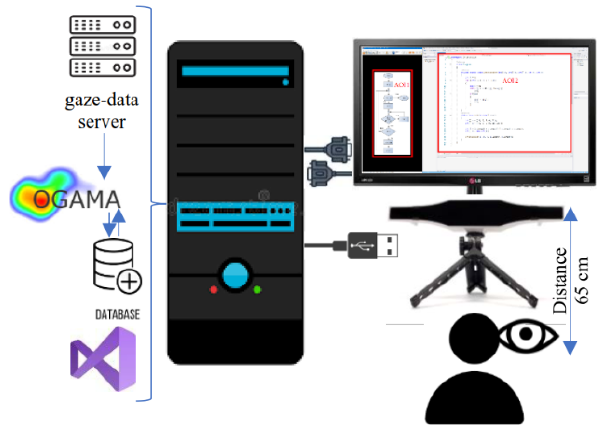
Figure 4. A schematic diagram of equipment setup (Reprinted from ref.[35]).